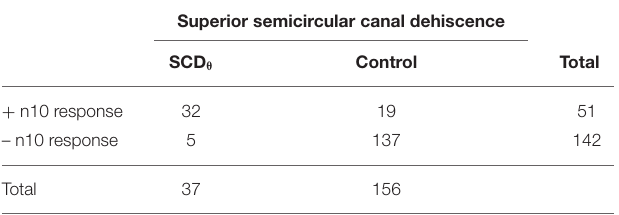
TABLE 2 | Frequency table for 4kHz oVEMP n10 response for diagnosis of SCD θ